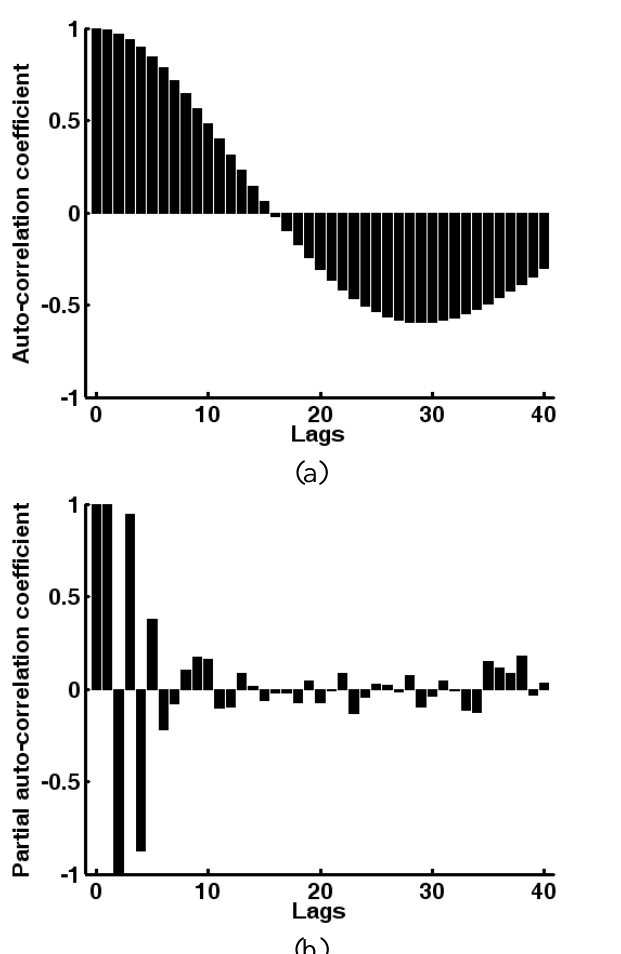
Figure 5. Analysis of ACF and PACF patterns: (a) ACF; (b)